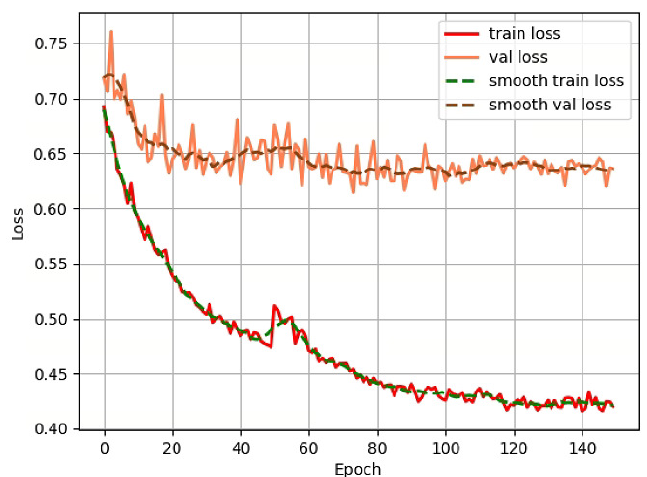
Figure 7. Training loss under the ECA-net+Resnet50 backbone network.